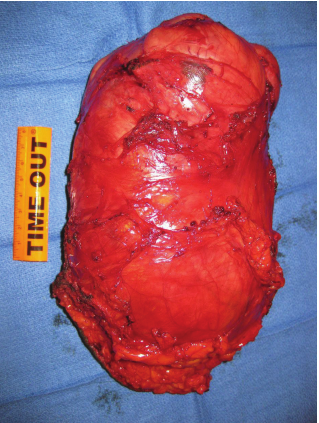
Figure 3: Resected mass measuring 24 × 12 × 8cm with smooth tan-pink surface and weighting 1660 gm. On sections, the mass shows areas of smooth, whorled tan-white tissue, with areas of cystic degeneration,edema,andrareslightlysofter,whiteopaqueareas.No hemorrhage or necrosis is identified